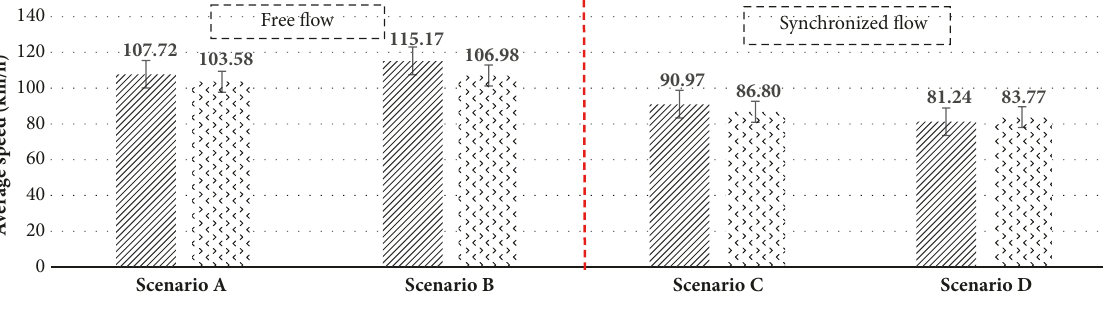
Figure 10: Impact of the gender on average speed of each scenario.